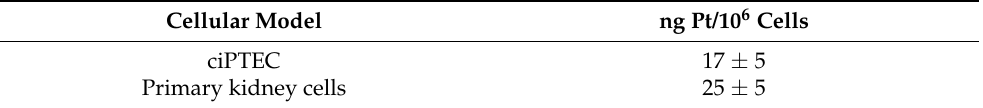
Table 2. Platinum accumulation in ciPTECs and primary kidney cells following incubation with 50 µ M cisplatin for 2 h. Shown are mean values from at least three independent determinations ± standard